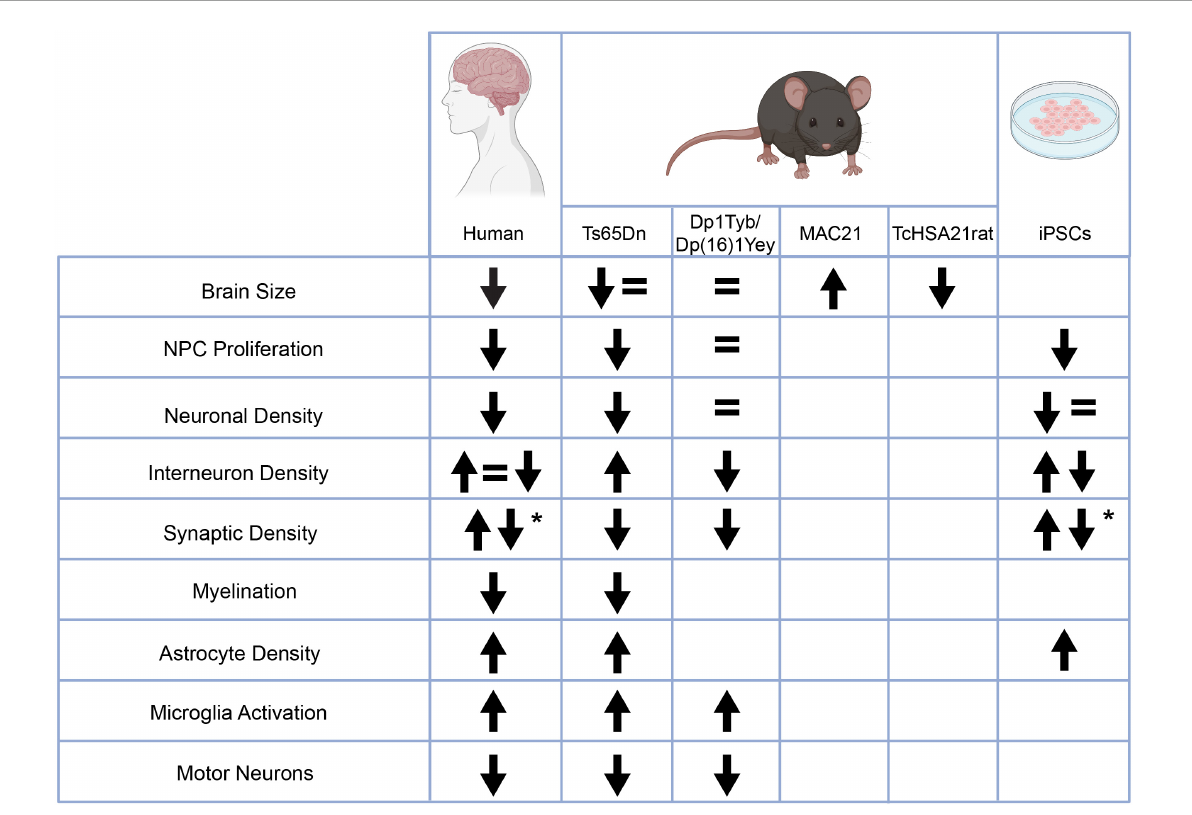
FIGURE2 Changes in neurodevelopmental characteristics in people with Down syndrome and various models relative to controls. Some of the observed phenotypes are inconsistent either from human studies or between humans and model systems. Other phenotypes are consistent within human studies and across model systems including an increase in astrocyte density, an increase in microglia activation, a decrease in motor neurons in the spinal cord, and changes in synaptic density. *The up and down arrows in the changes in synaptic density indicate an age dependent phenotype. This figure was created with